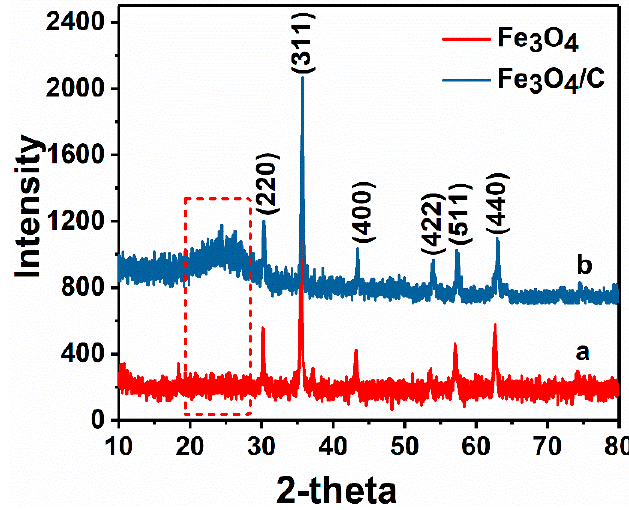
/ C composite (curve